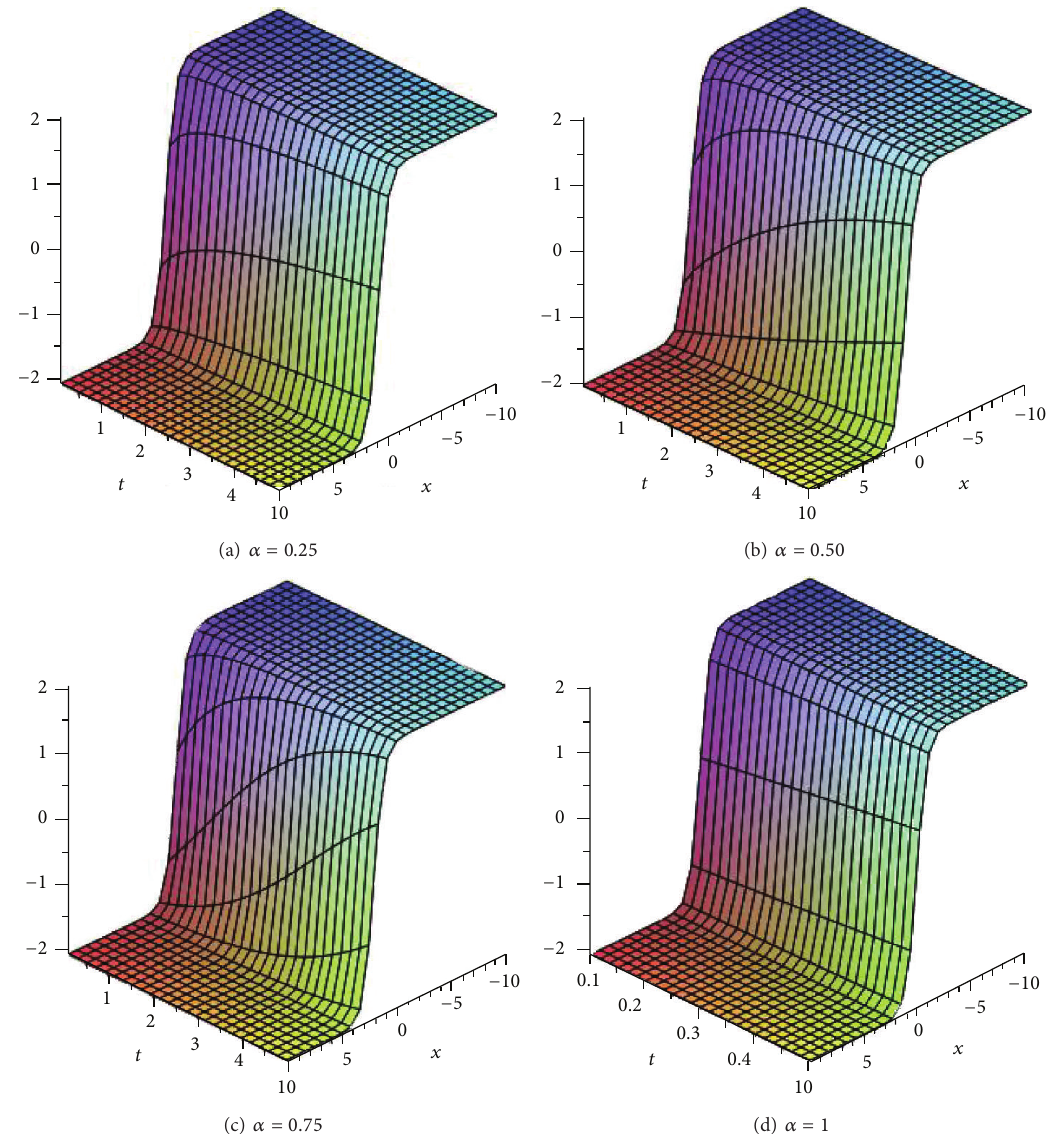
Figure 1: (a)–(d) show the kink solution for 𝑢 1 1 for different values of parameters.